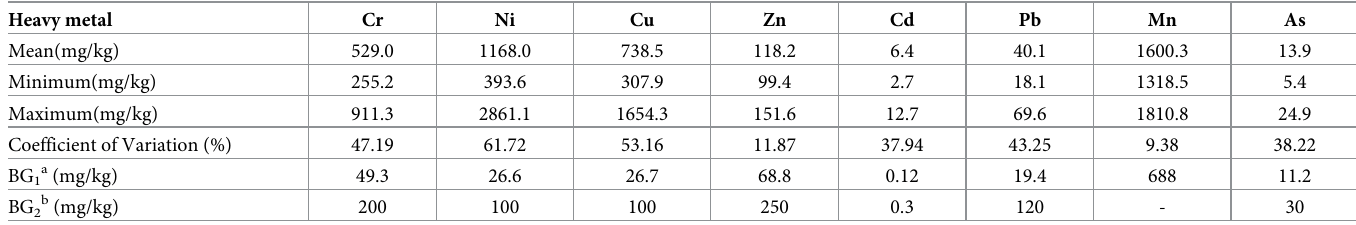
Table 2. Statistics for heavy metal content in the soil around the tailing reservoir area (n =